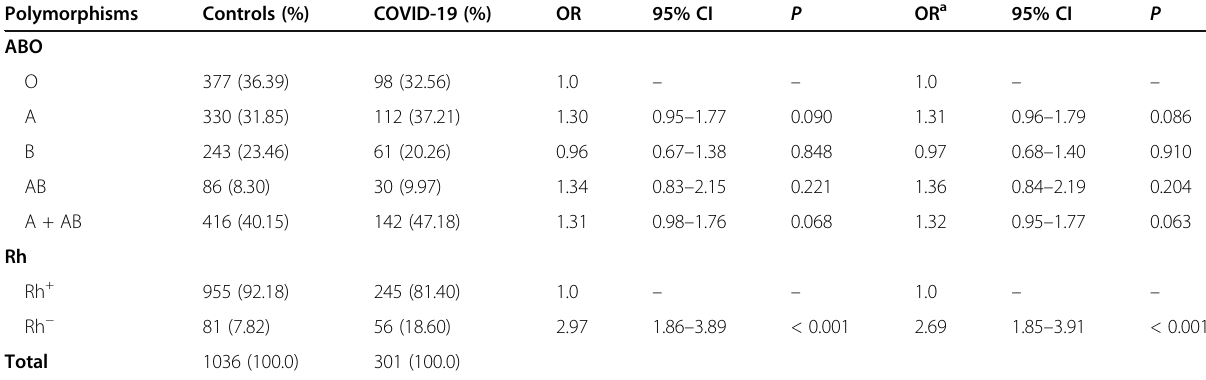
Table 1 Frequency of ABO and Rh blood groups in control and COVID-19 patient groups Polymorphisms